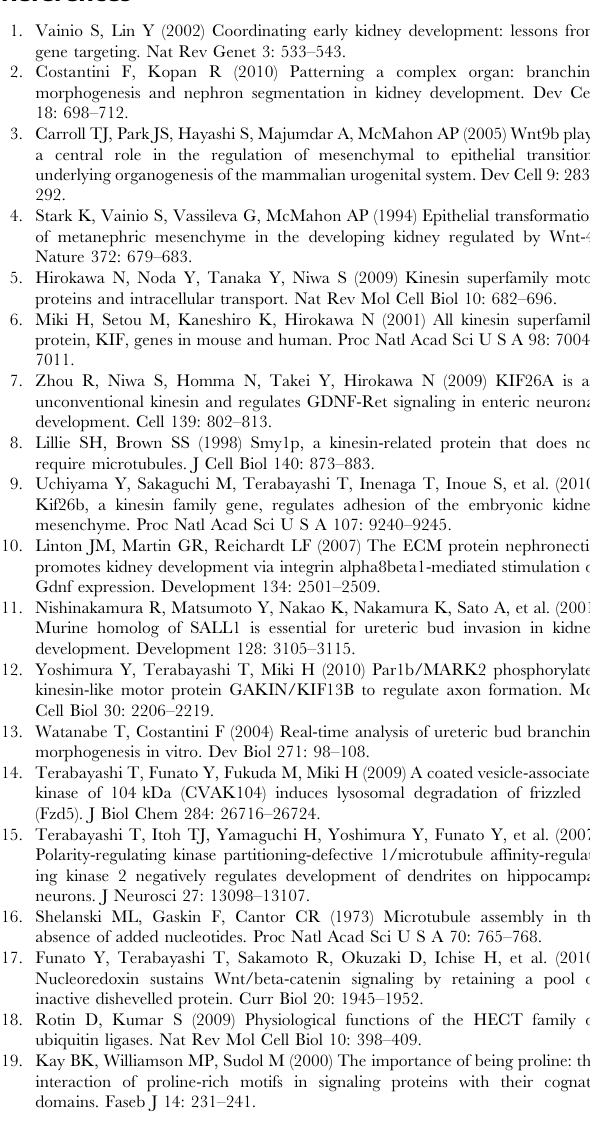
were subjected to SDS-PAGE and immunoblotting with the indicated antibodies. Figure S4 Nedd4 is expressed in developing kidney. In situ hybridization showed Nedd4 was expressed in all components of developing kidney such as the metanephric mesenchymes, comma-shaped bodies and the ureteric epithelia. No signal was observed with the sense control probe. Scale bar, 100 m m. Figure S5 Interaction of Kif26b with CDK5 and expres- sion of Kif26b in the developing kidney. A . Kif26b was immunoprecipitated from E14.5 kidney lysates with anti-Kif26b antibody, and precipitates were analyzed by immunoblotting with